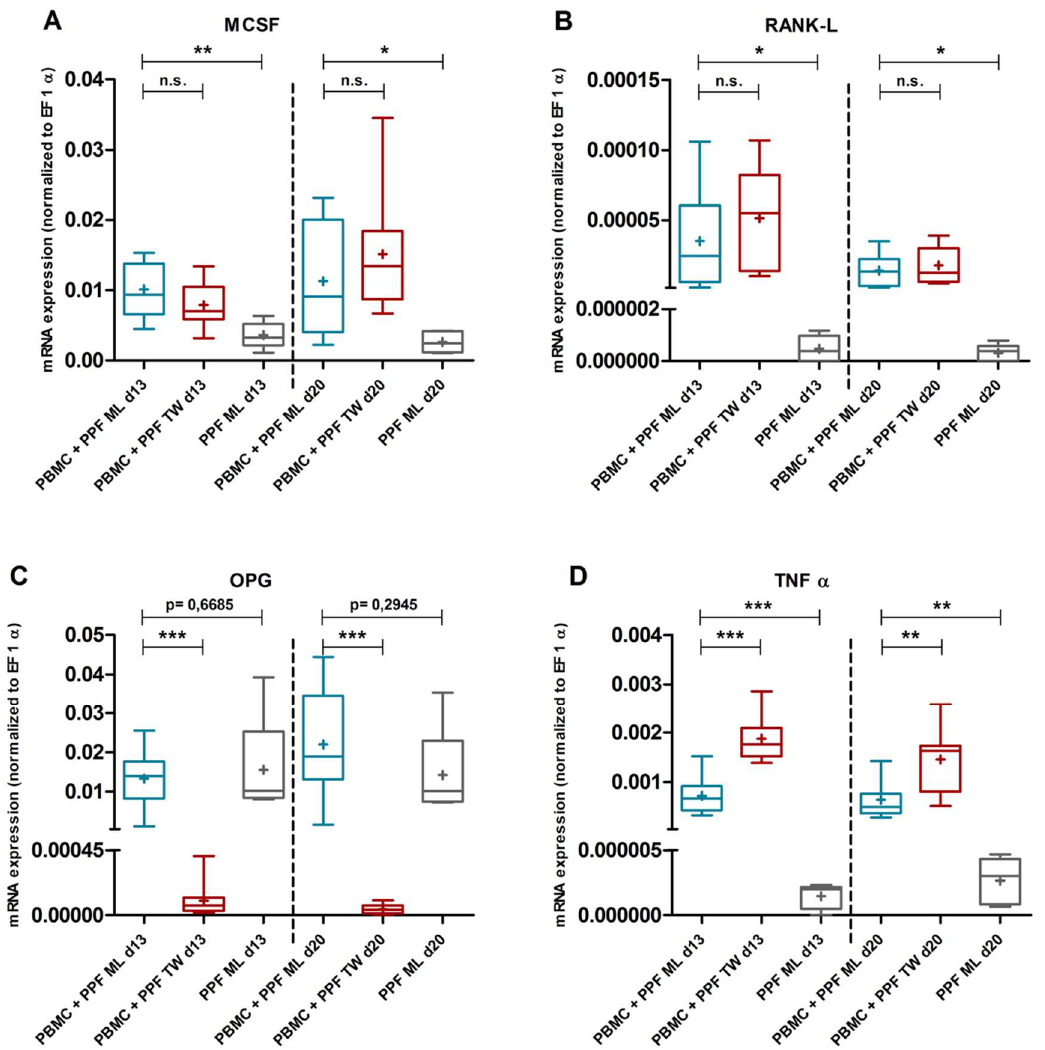
Figure 4. mRNA expression of PPF monocultures and PPF/PBMC co-cultures. Relative mRNA expression (normalized to housekeeping gene EF 1 α ) of MCSF ( A ), RANK-L ( B ), OPG ( C ), and TNF α ( D ) in co-cultures of PPFs and PBMCs in monolayer (ML, n = 10) and transwell (TW, n = 10) as well as in monocultures of PPFs in monolayer ( n = 5) on d13 and d20. Bands inside the boxes represent group medians, crosses indicate group means. End of whiskers represent minimum and maximum values. p values are indicated with * ( p ≤ 0.05), ** ( p ≤ 0.01), and *** ( p ≤ 0.001).